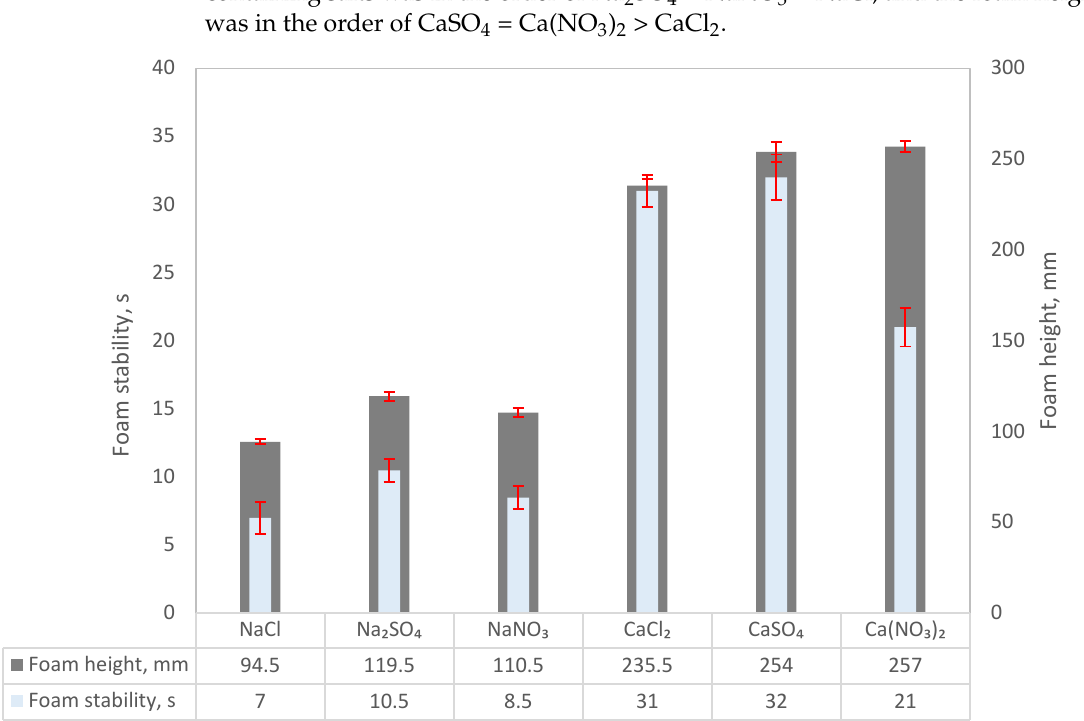
Figure 5. Specific ion effects on foam stability and foam height.